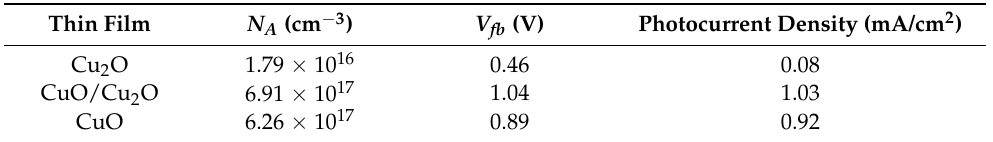
Table 1. Experimental values of carrier density ( N A ), flat band potential ( V fb ), and photocurrent density for p-type Cu 2 O, CuO/Cu 2 O, and CuO thin